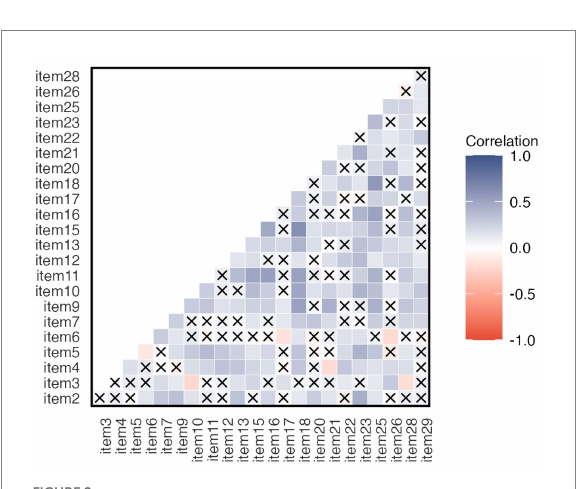
FIGURE 2 Inter-item tetrachoric correlation coefficients for the 23-item Rotter I-E Scale. “x” indicates non-significant correlations ( p > 0.05). Inter-item correlation ranged between − 0.22 and 0.62. 15.42% correlations were higher than